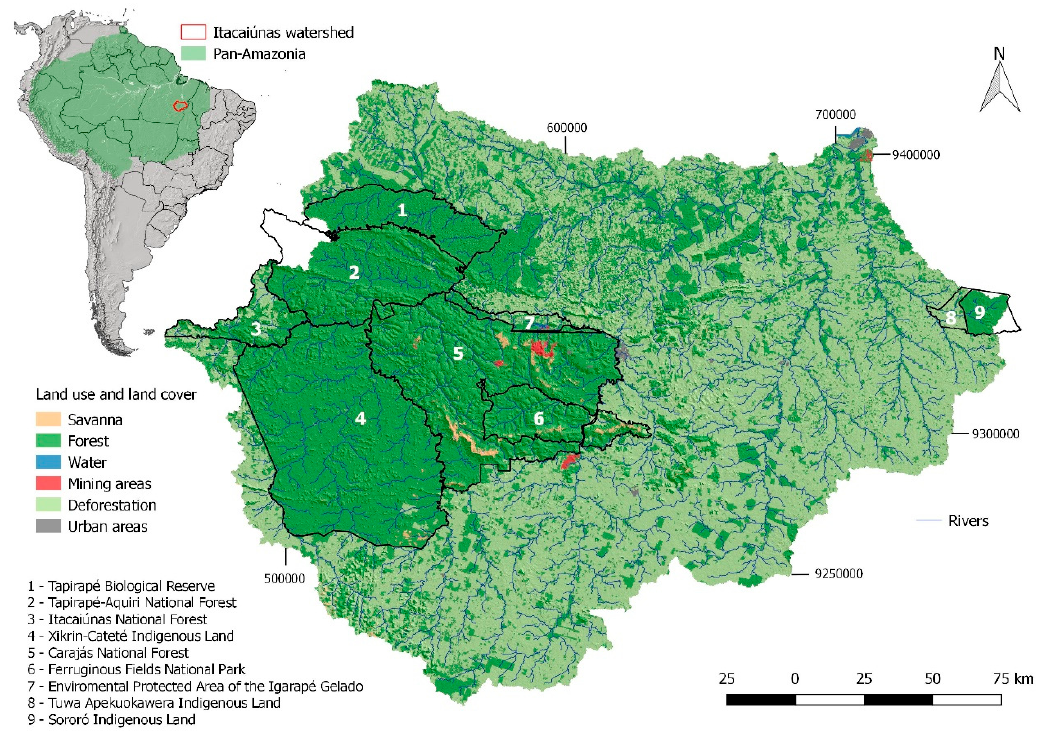
Figure 1. Study area, the Itacai ú nas watershed, located in the state of Par á , southeastern Brazilian